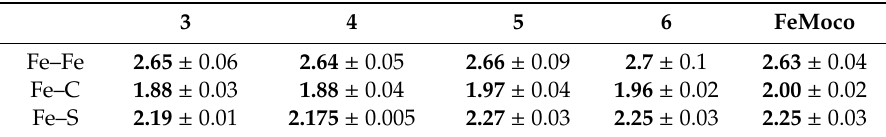
Table 1. Selected bond distance averages of the FeCS clusters described in this work compared with the corresponding averages found in the nitrogenase cofactor